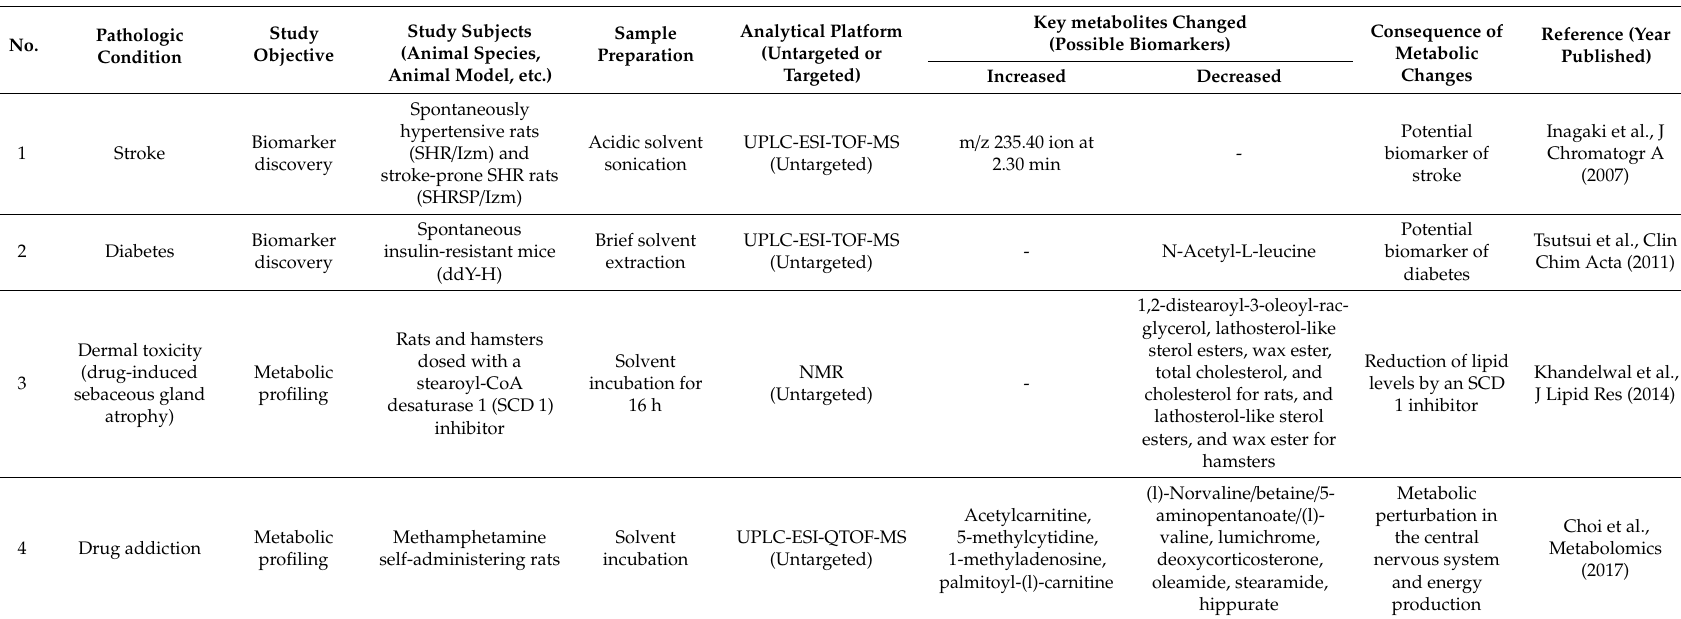
Table 1. Use of hair metabolomics in animal